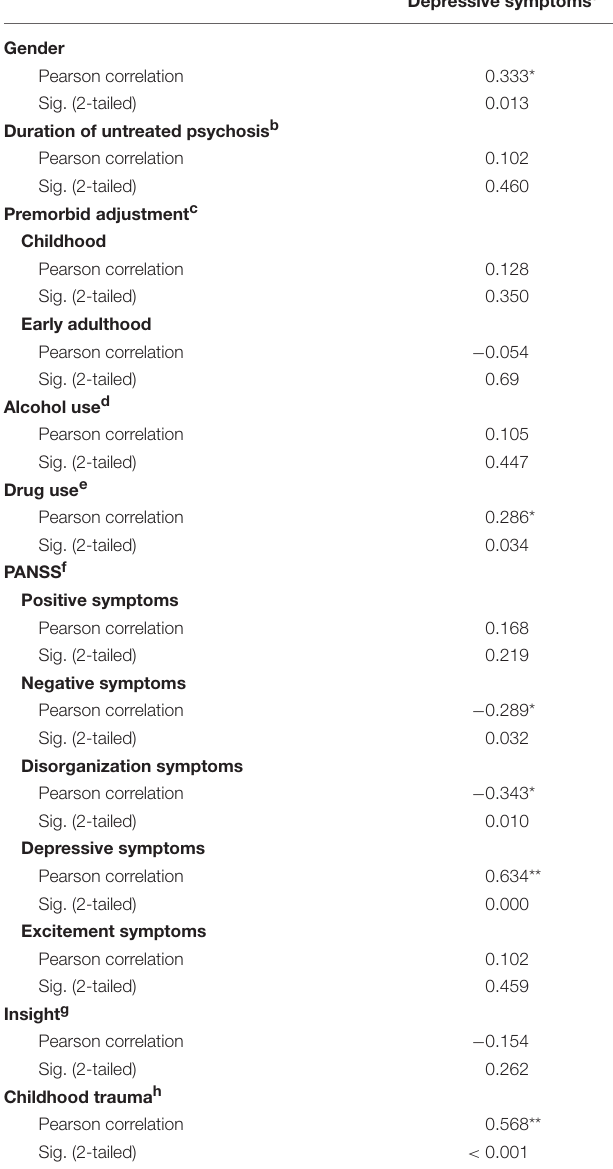
TABLE 2 | Hierarchical regression analysis with depressive symptoms as the dependent variable and ASEs and self-esteem as independent variables, demonstrating mediating effects of self-esteem.